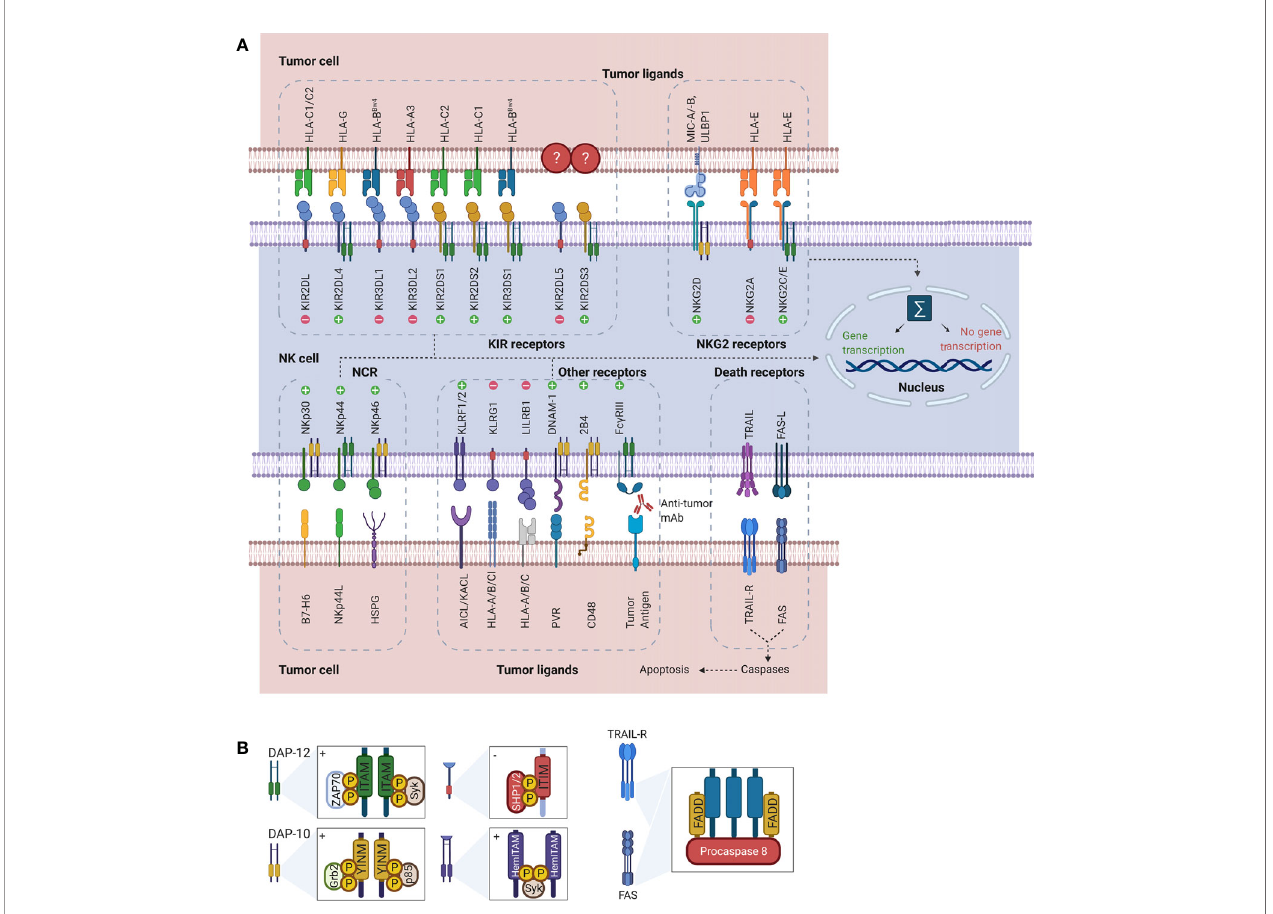
FIGURE 2 | Representation of NK cell receptor-ligand interactions and signaling motifs that enable downstream cell signaling. (A) The most common NK cell receptor families are illustrated together with their ligands. While some receptors engage multiple ligands, others such as KIR2DL5 and KIR2DS3/S4/S5 have no known ligands. Interaction of ligands with receptors causes activation of downstream signaling pathways. Depending on the type of receptor, this may cause either activation of gene transcription or suppression. (B) Downstream signaling is activated through processing of the receptors-ligand interaction through signaling motifs. Symbols “ + ” and “ - ” in the boxes indicate activating and inhibiting signaling. While ITAM and YINM signaling motifs are bound to DAP-10 and -12 adaptor protein respectively, ITIM and HemITAM are present on the receptors and do not require adaptor proteins. The death receptors Fas and TRAIL-R signal through FADD to induce induction of apoptosis in tumor cells. Downstream signaling and gene transcription leading to NK cell activation is dependent on the sum of all activating and inhibiting signals. AICL, Activation-induced C-type lectin; DAP, DNAX-activating protein; DNAM, DNAX accessory molecule; FADD, Fas-associated protein with DD; Grb2, Growth factor receptor-bound protein 2; HemITAM, Hemi-immunoreceptor tyrosine-based activation motif; HLA, Human leukocyte antigen; HSPG, Heparan sulfate proteoglycans; ITAM, Immunoreceptor tyrosine-based activation motif; ITIM, Immunoreceptor tyrosine-based inhibitory motif; KACL; Keratinocyte-associated C-type lectin, KIR, Killer cell immunoglobulin-like receptor; KLRF/G, Killer cell lectin-like receptor F/G; LILRB1, Leukocyte immunoglobulin-like receptor B1 MICA/B, MHC class I polypeptide – related sequence A/B; NCR; Natural cytotoxicity receptors; NK, Natural killer; NKG2, Natural killer group 2; PVR, Poliovirus receptor; SHP1/ 2, Src homology region 2 domain-containing phosphatase-1; Syk, Spleen tyrosine kinase; TRAIL(R), TNF-related apoptosis-inducing ligand (receptor); ULBP, UL16 binding protein; YINM, Tyrosine-based signaling motif; ZAP70, Zeta-chain associated protein